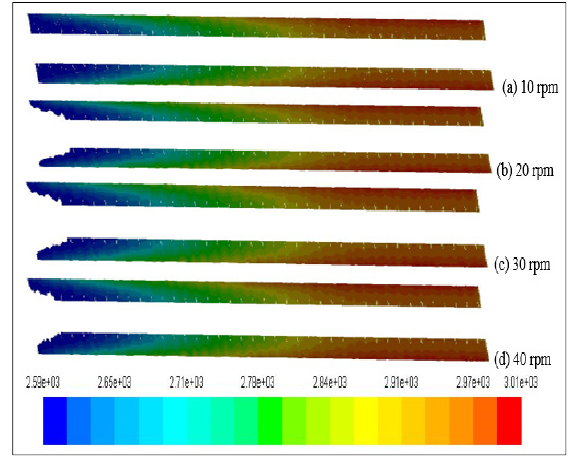
Fig. 10. Density Contour plane at 500 gm.